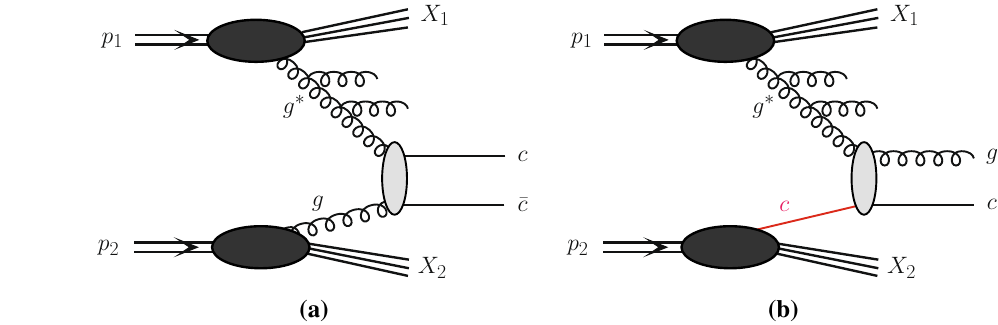
Fig. 3 A sketch of the a gg ∗ → c ¯ c and b cg ∗ → cg production mechanisms in pp -interactions within the hybrid